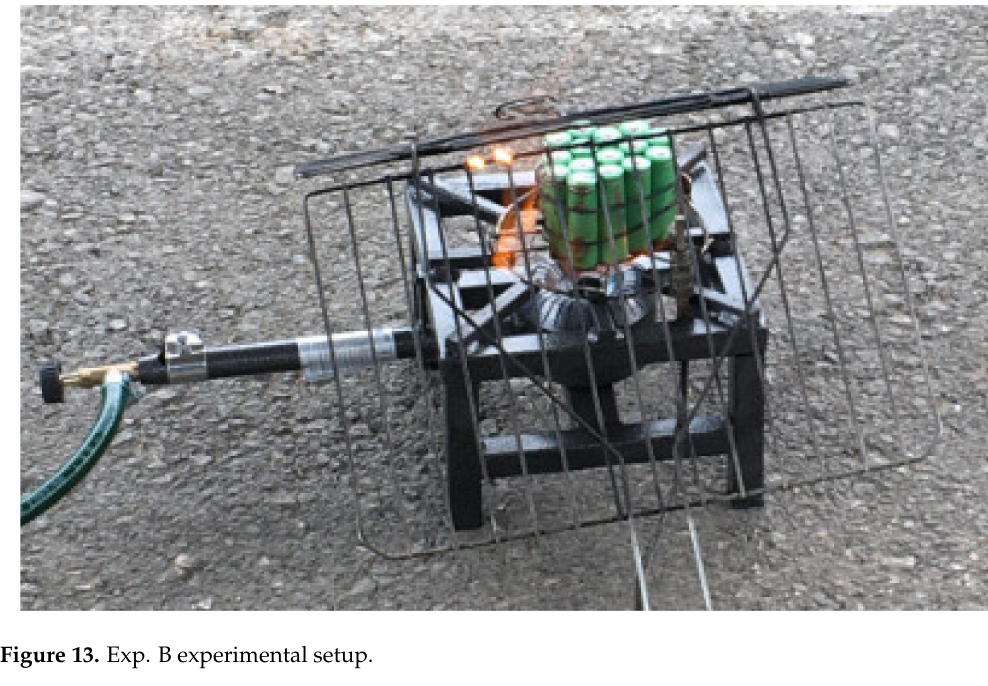
Figure 13. Exp. B experimental setup.